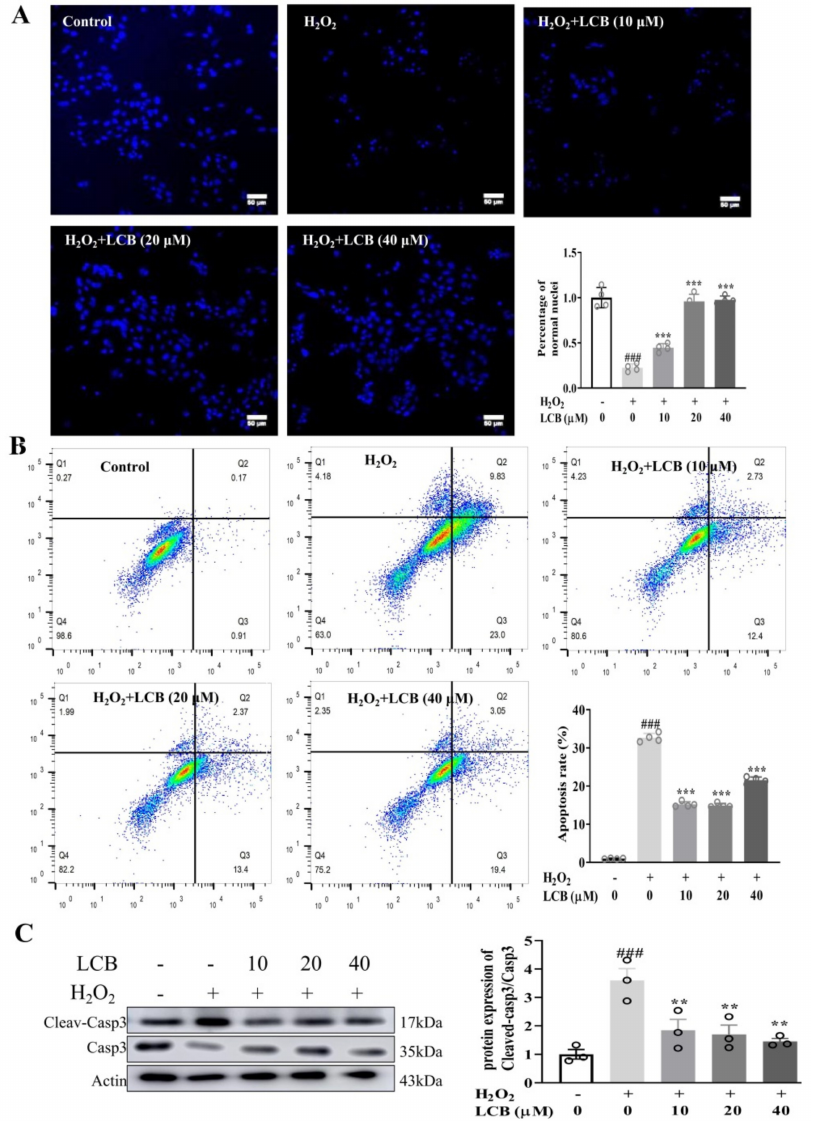
Figure 4. LCB protected PC-12 cells from apoptosis induced by H 2 O 2 . ( A ) PC-12 cells were pretreated with 10, 20, or 40 µ M of LCB for 16 h before exposure to 900 µ M H 2 O 2 for 6 h. Hoechst 33342 staining was performed in cells for 10 min. Scale bar = 50 mm. *** p < 0.001 ( B ) PC-12 cells were pretreated with 10, 20, and 40 µ M of LCB for 16 h before exposure to 900 µ M H 2 O 2 for 6 h. Apoptotic cells detected by using annexin/propidium iodide (PI) double staining were quantitated by flow cytometry. ( C ) PC-12 cells were pretreated with LCB (10 to 40 µ M) for 16 h before being subjected to 900 µ M H 2 O 2 for 6 h. Western blot analysis was used to detect the level of cleaved or total caspase-3 protein expression, ** p < 0.01, ### p < 0.001, H 2 O 2 group vs. control; *** p < 0.001, H 2 O 2 + LCB group vs. H 2 O 2 group. The original uncropped images of Western blotting are shown in Supplementary Figure